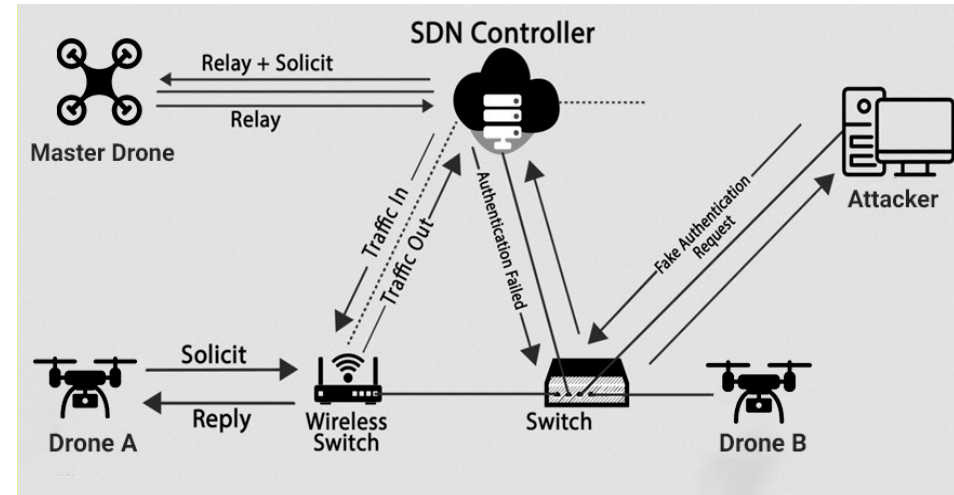
Figure 7. Actual authentication Mechanism.